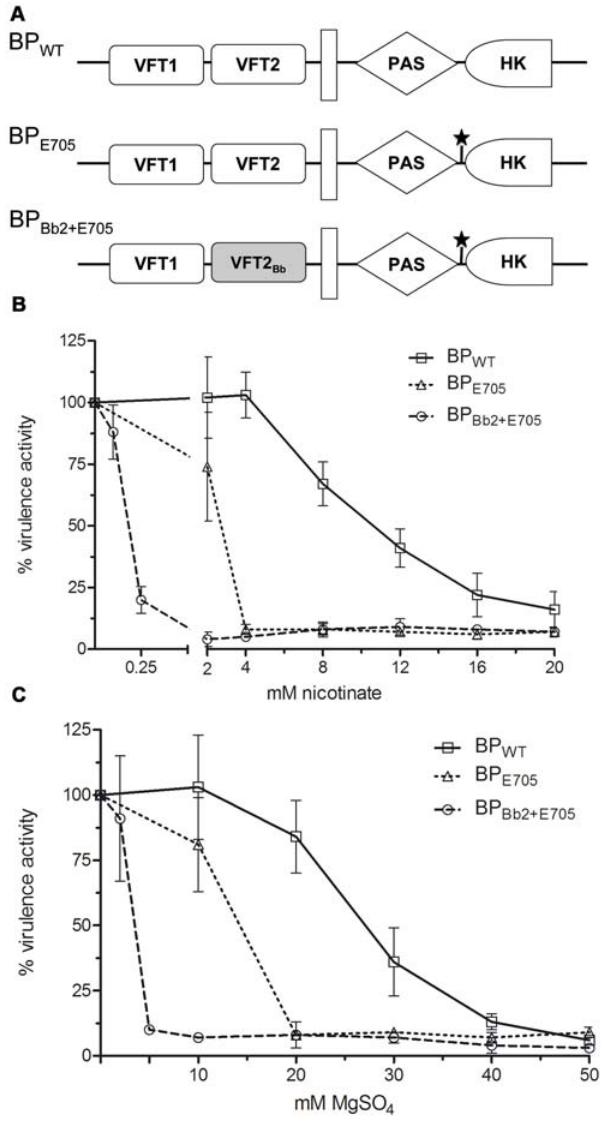
Figure 5. ß-galactosidase activities of the recombinant BPSM( ptx::lacZ ) strains harbouring BvgS variants. (A) Schematic representation of the chimeric BvgS. The BvgS domains are represented as in Fig. 4. The star indicates that the Lys705 residue found in Tohama I was replaced by Glu as in all other isolates. (B) and (C) The ß-gal activities were measured as a function of increasing concentrations of nicotinate or MgSO 4 . The measurements were performed as in Fig. 4.